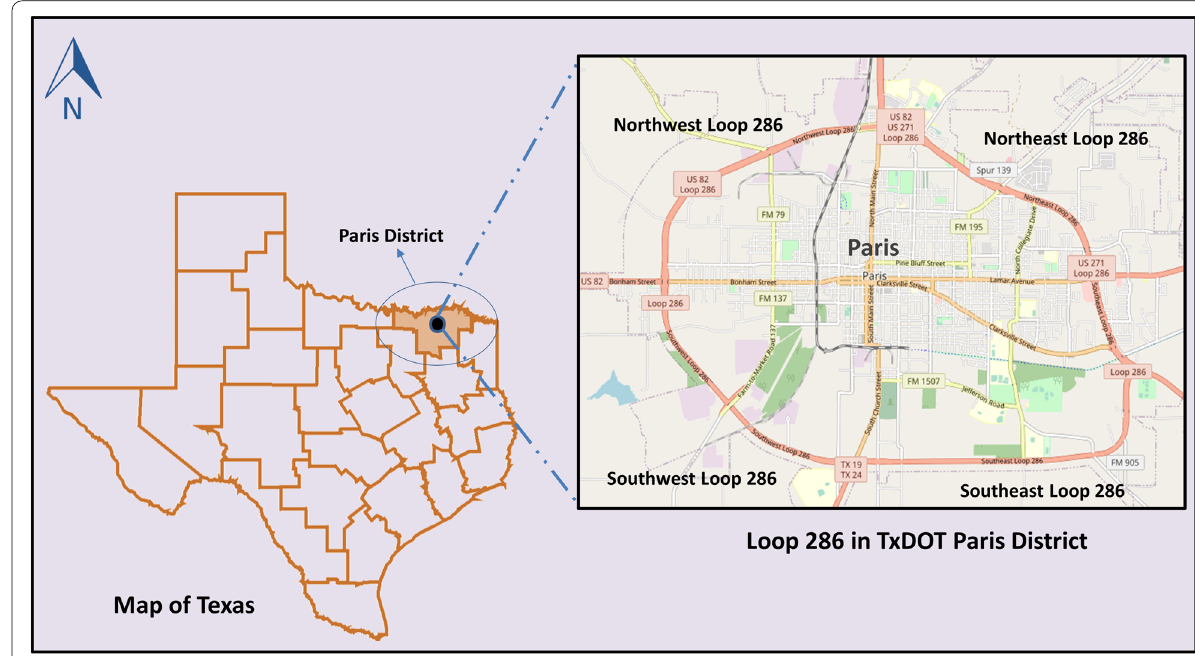
Fig. 5 Loop 286 in the TxDOT Paris